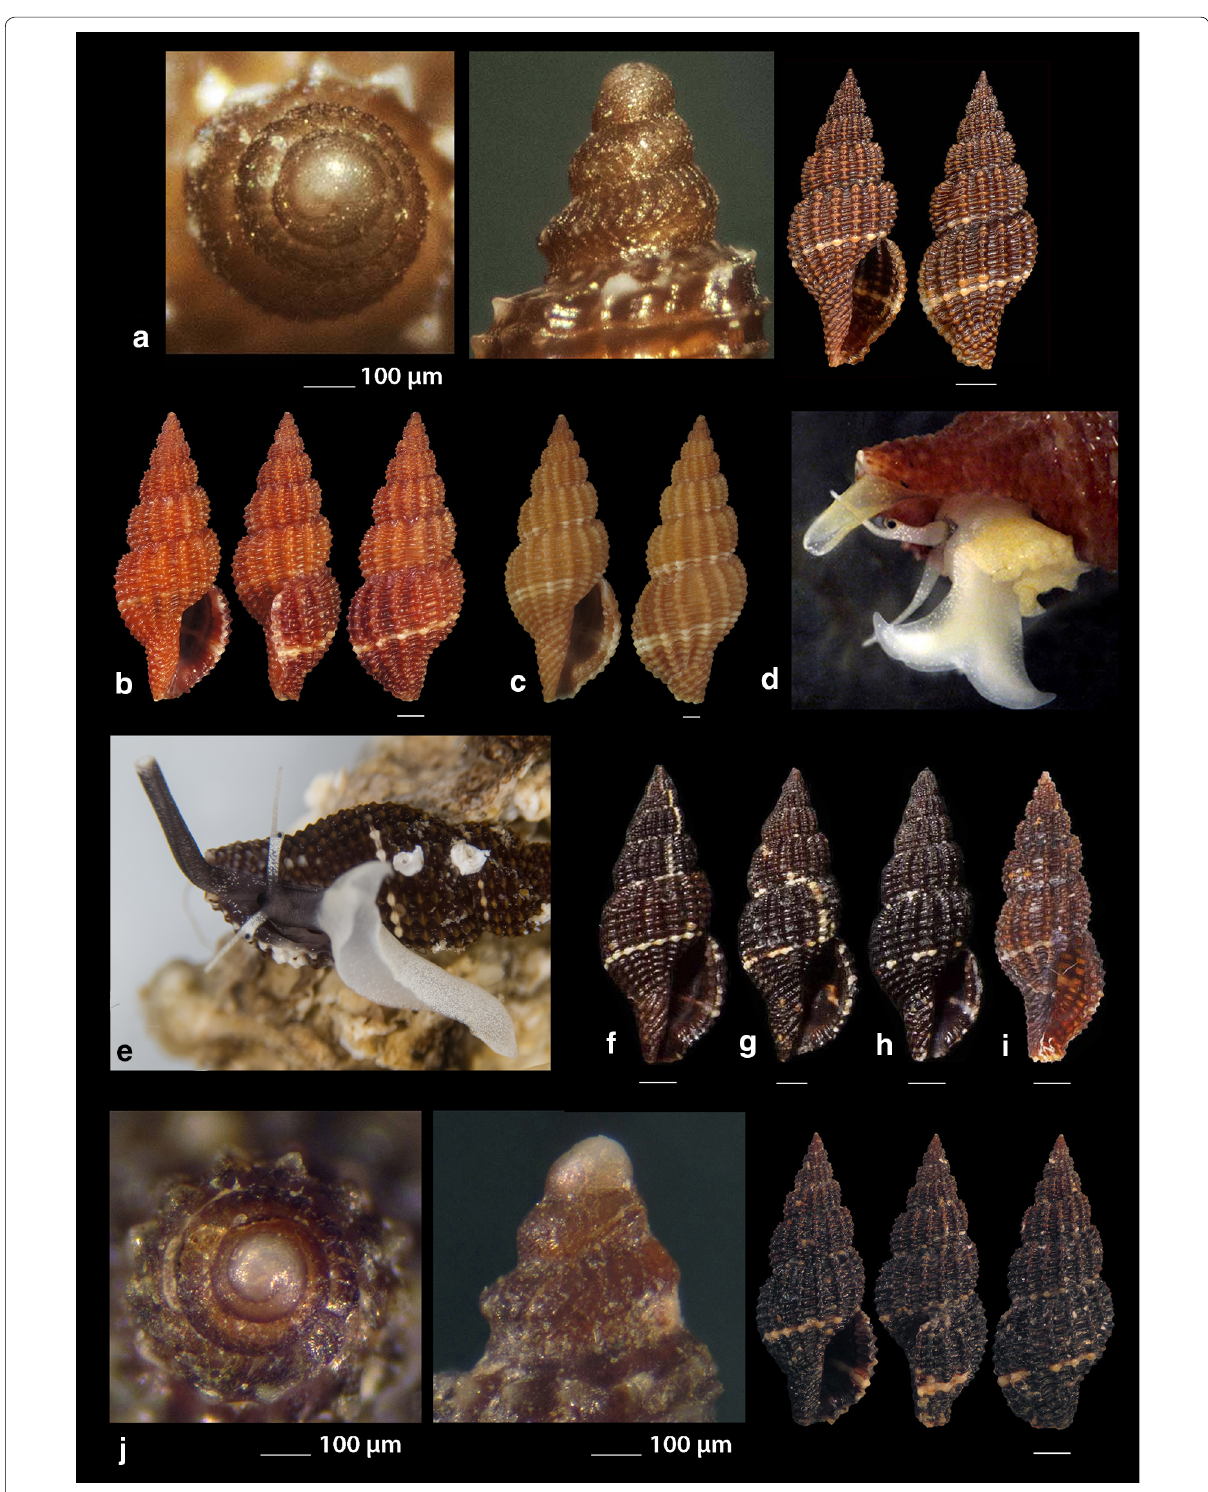
Fig. 4 a – j Raphitoma atropurpurea , a – d deep water form, d live specimen of deep water form, e – j shallow water form, e live specimen of shallow water form. Bar 1 mm, unless otherwise =